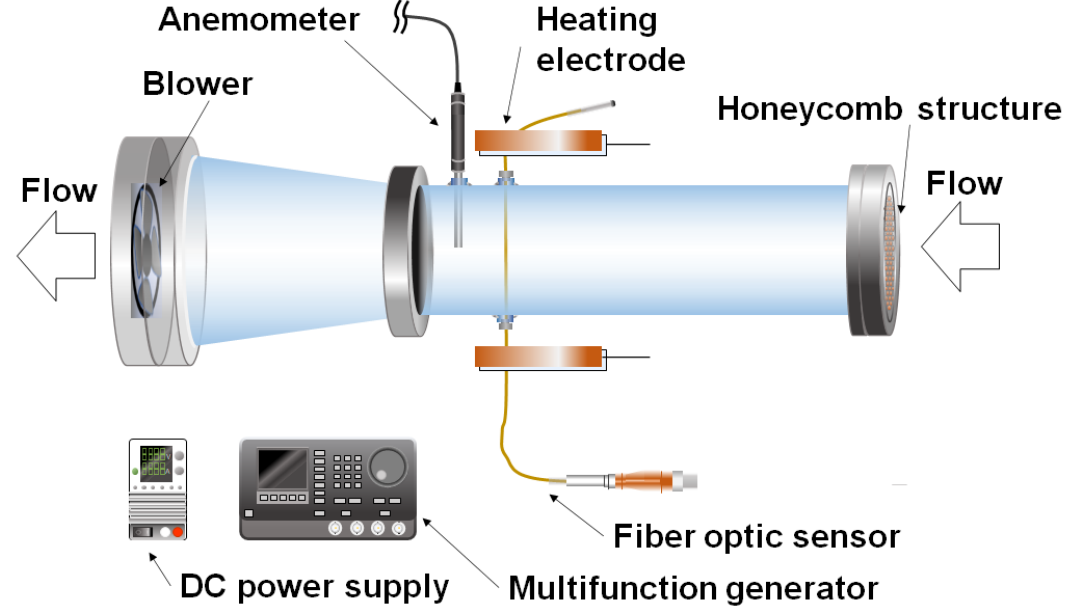
Figure 3. Velocity calibration of the fiber optic sensor in a wind tunnel. Table 1. Test parameters and their ranges.